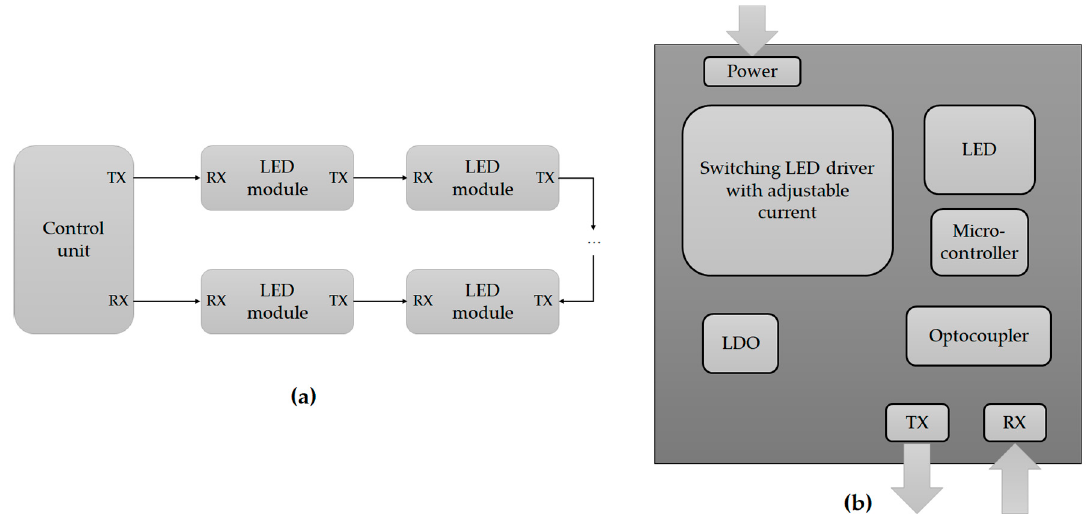
Figure 2. ( a ) Lighting system block diagram. ( b ) LED lighting module block diagram. TX: Transmitter, RX: Receiver, LDO: Voltage regulator.